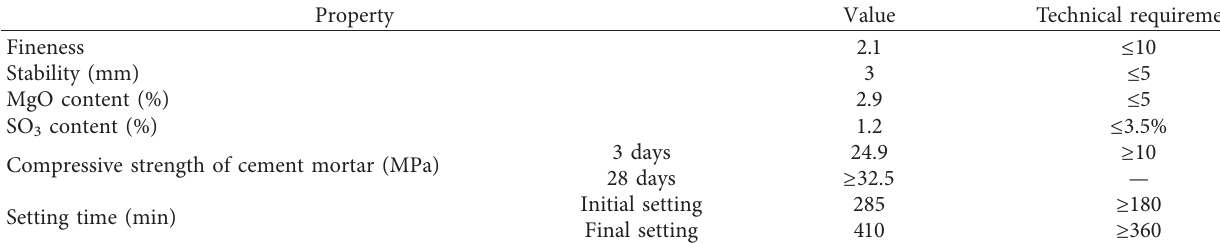
Table 1: Properties of PSB32.5R cement.